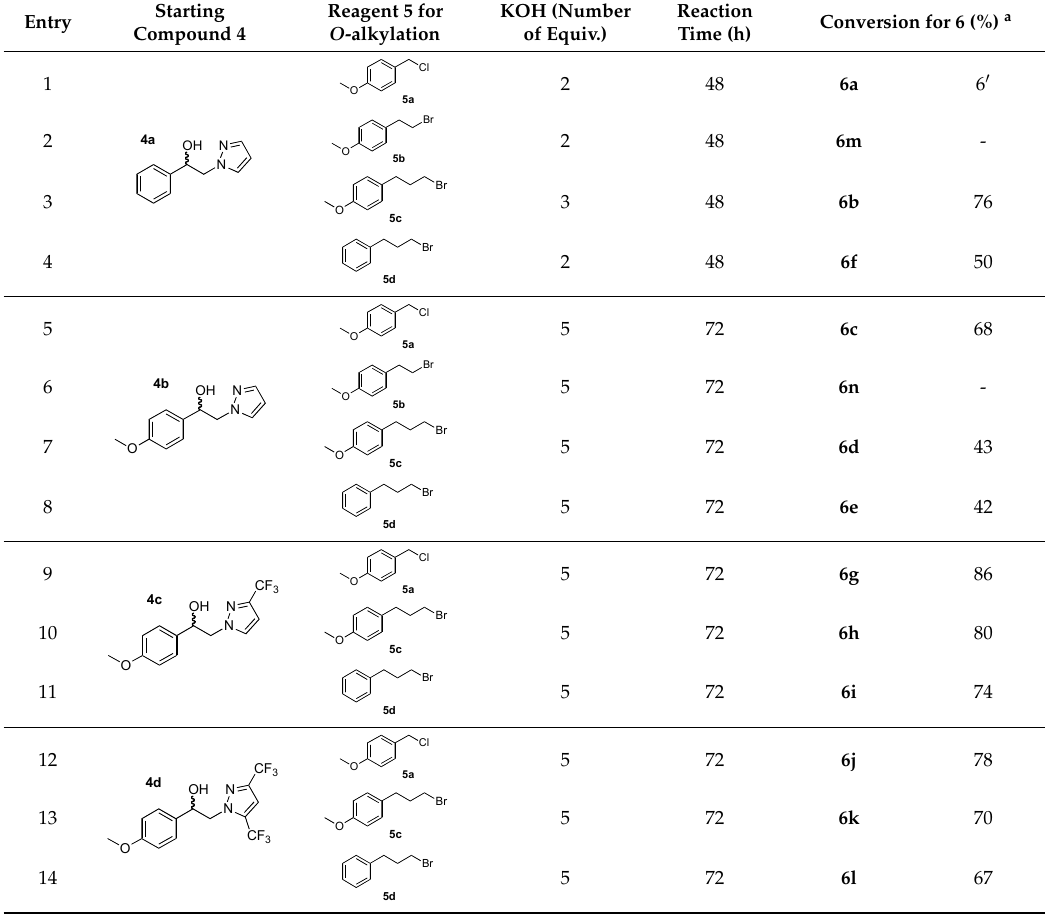
Table 2. Optimization of the reaction conditions for the preparation of the intermediates 6a – n . Reagent 5 for KOH (Number Entry Starting Compound 4 O -alkylation of Equiv.)